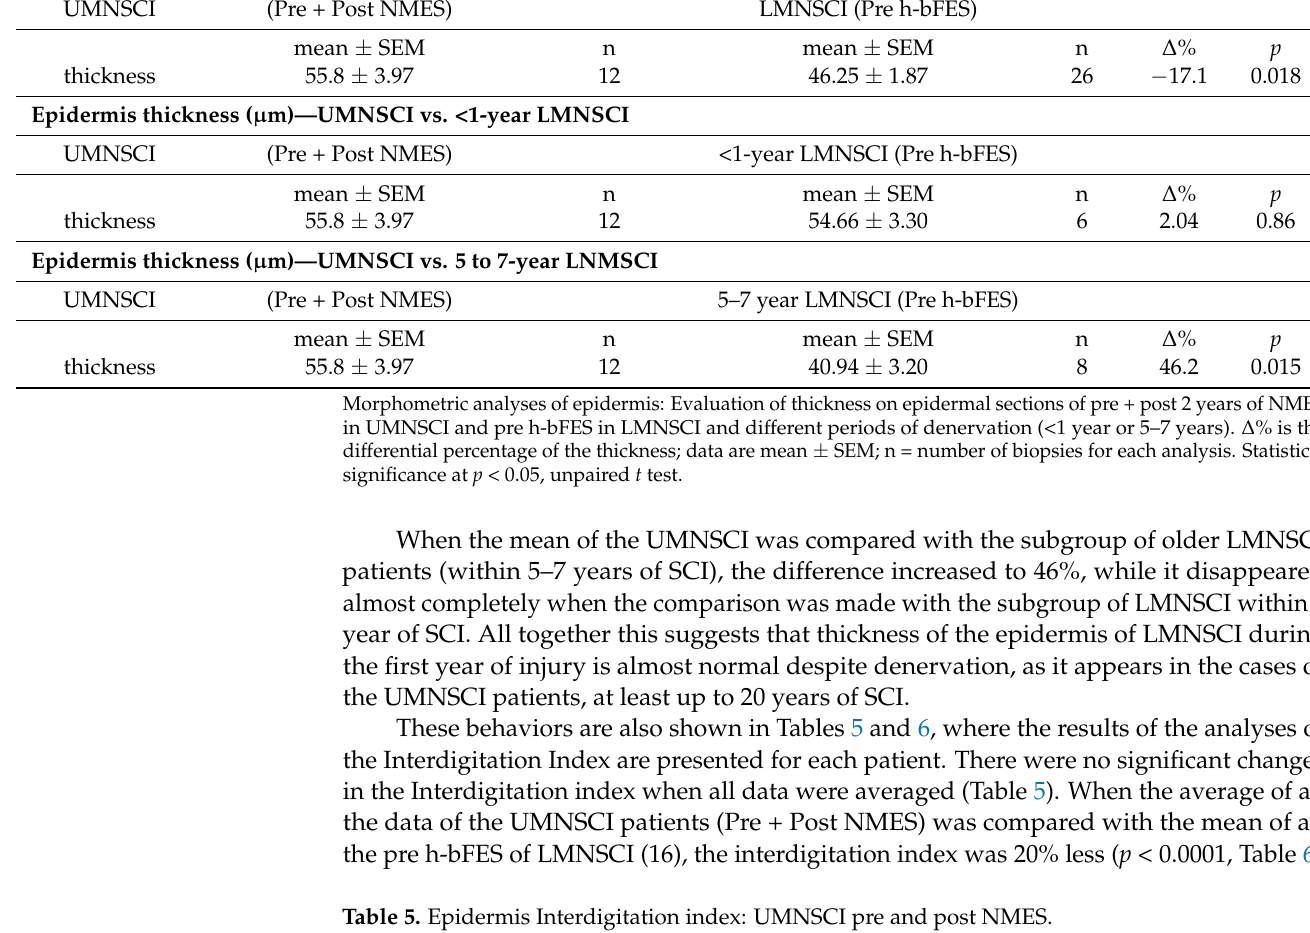
Table 5. Epidermis Interdigitation index: UMNSCI pre and post